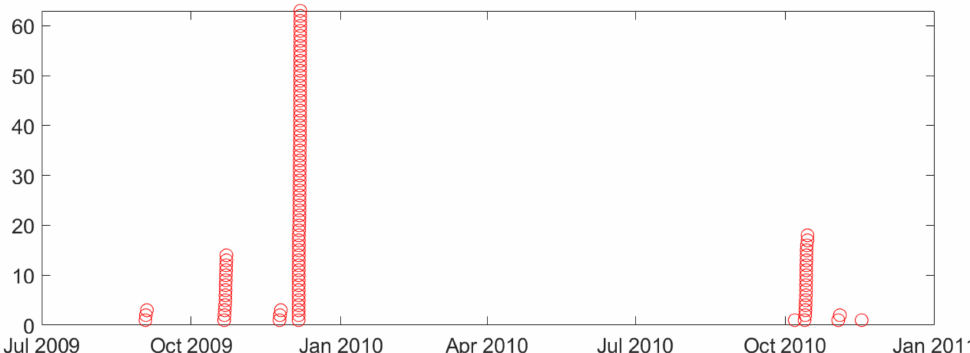
Figure A1. Clustering of seizures for canine data (L7): Explanation: among all 105 seizures (shown in red circles), 103 seizures occur in clusters, 2 seizures are isolated. Using T = 3 days, 8 clusters (~lead seizures) can be detected. Cluster duration is between 1 to 2 days, duration between two lead seizures is between 6 and 304 days.